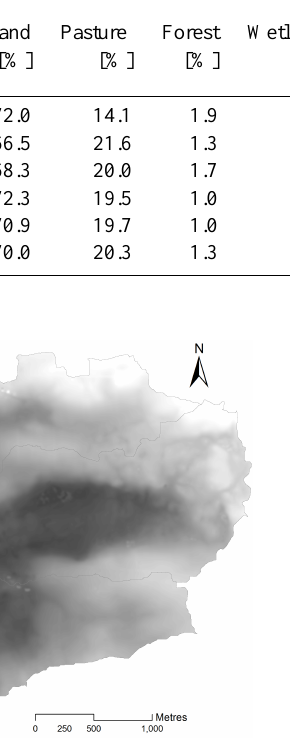
Fig. 3. Elevation model (2 × 2m, based on the airborne laser- scanning by Hansen, 2004) with locations of sampling points along the three stream sections with corresponding subcatchments. Nu- meric labels indicate the number of the sampling